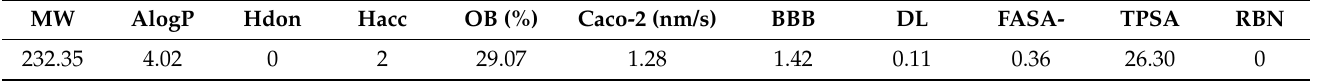
Figure 2. Potential targets of costunolide in AIH: ( a ) 2D structure of costunolide (PubChem Identi- fier: CID 5281437 https://pubchem.ncbi.nlm.nih.gov/compound/5281437#section=2D-Structure (accessed on 26 February 2022)), ( b ) Venn diagram of intersecting targets of costunolide and AIH. Table 1. Pharmacological and molecular properties of